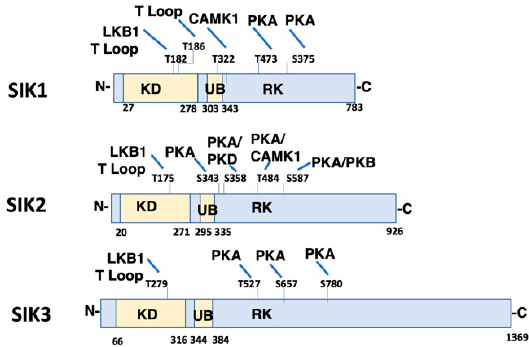
Figure 1. Domain Structure and Phosphorylation Sites of Salt Inducible Kinase (SIK) Isoforms. The domain structure of SIK1 (Uniprot P507059), SIK2 (Uniprot Q9Y2K2), and SIK3 (Uniprot Q9Y2K2) is shown including conserved Kinase Domain (KD), Ubiquitin Associated Domain (UB), and RK-rich region (RK). Identified phosphorylation sites are also illustrated, as well as the corresponding kinase (LKB1 (T182 SIK1, T175 SIK2, T221 SIK3), CaMK1 (T322 SIK1, T484 SIK2), PKA (T473 and S575 SIK1; S343, S358, T484 and S587 SIK2; T469, S551, S647 SIK3), and PKB (S587 SIK2)). T Loop indicates that the phosphorylation site is within the T activation loop. The amino and carboxy terminus of each SIK isoform are indicated by N- and C-, respectively. CaMK1, Calmodulin Activated Protein Kinase 1; PKA, Protein Kinase A; PKB, Protein Kinase B.